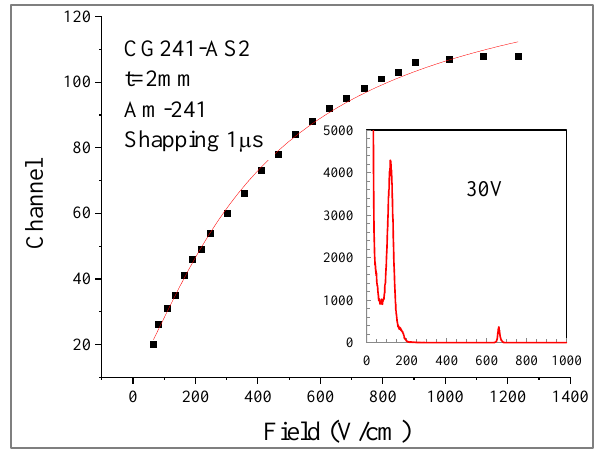
Figure 12. µτ e measurements (2.9 × 10 −4 cm 2 /V) and gamma response to 241 Am for CRY-2.